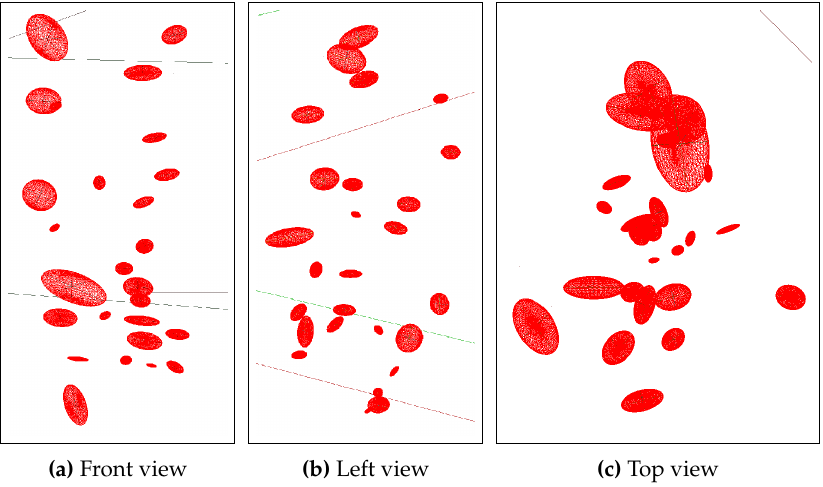
Figure 18. Histogram showing volume and velocity distribution of the bubbles.